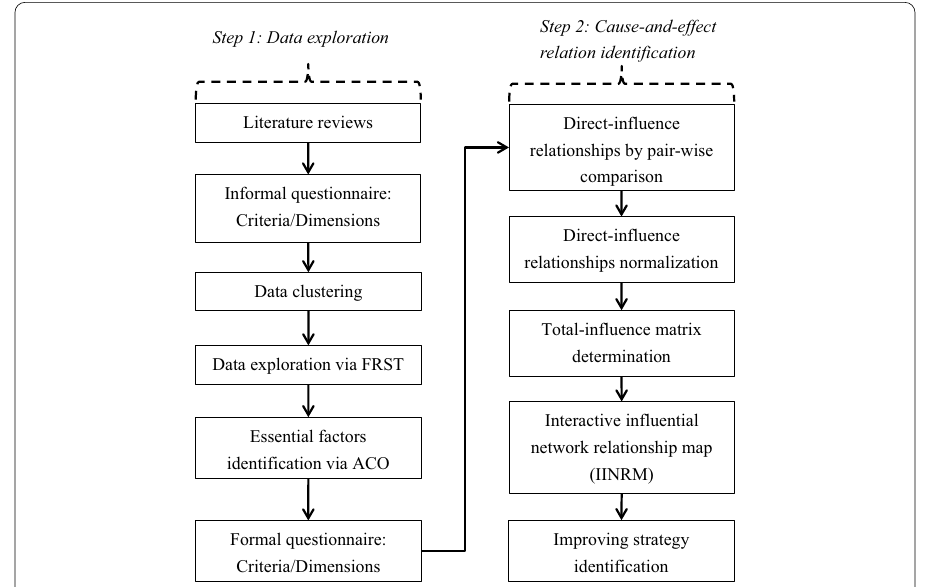
Fig. 1 The flowchart of the introduced hybrid